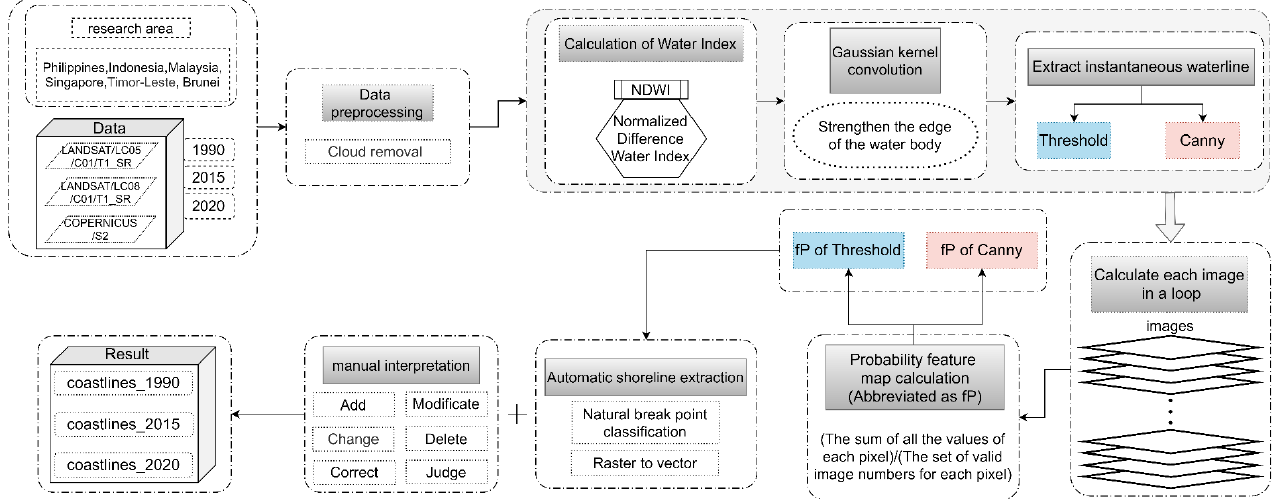
Figure 1. Workflow of the coastline extraction method based on the remote sensing big data platform Google Earth Engine and dense time-series remote sensing images.